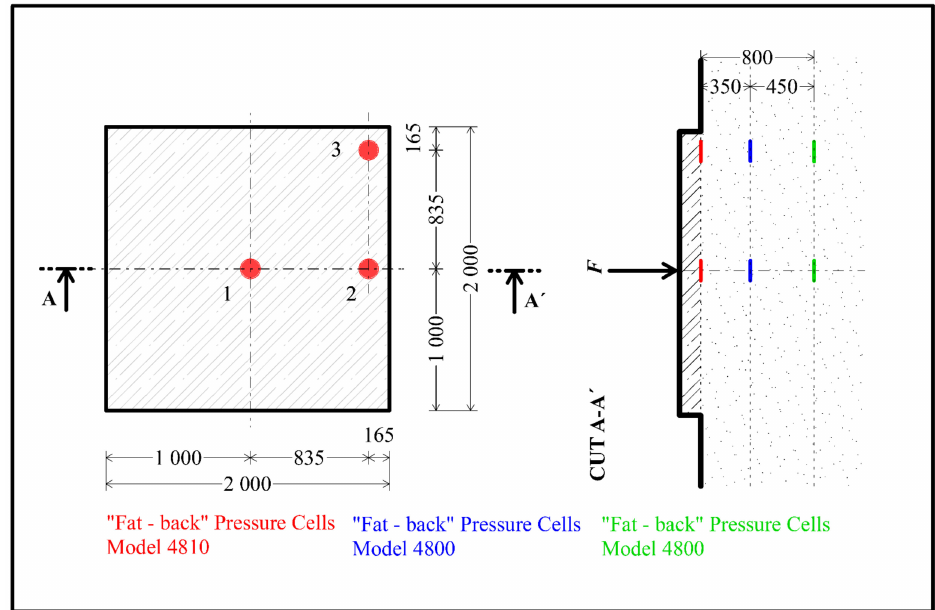
Figure 24. Schema of pressure cells in subsoil for centrically loaded slab G10 and eccentrically loaded slab